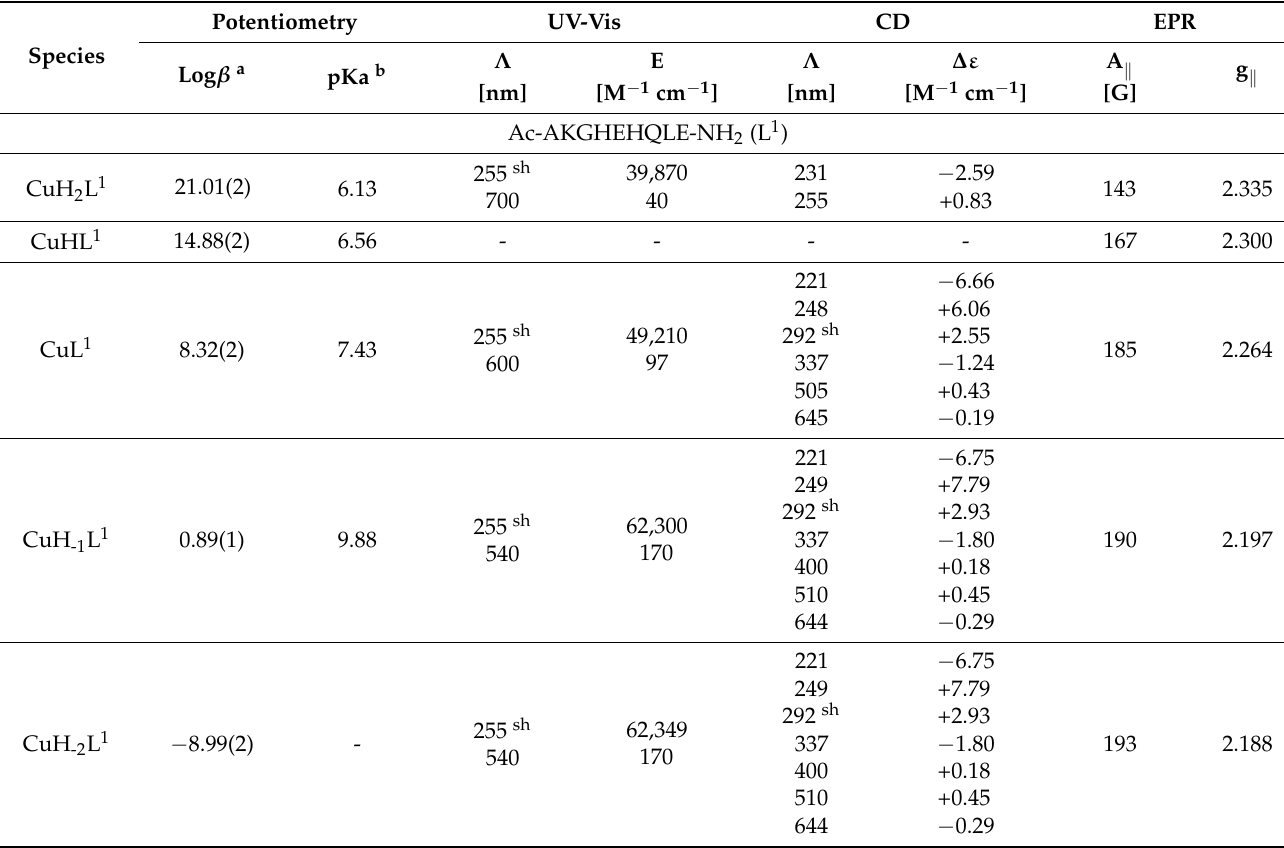
Table 1. Thermodynamic and spectroscopic parameters for deprotonation and Cu(II) complex formation of fragments of porin protein P1 in aqueous solution. T = 25 ◦ C, I = 0.1 mol dm − 3 (KCl). Standard deviations are given in parentheses. Potentiometry Species